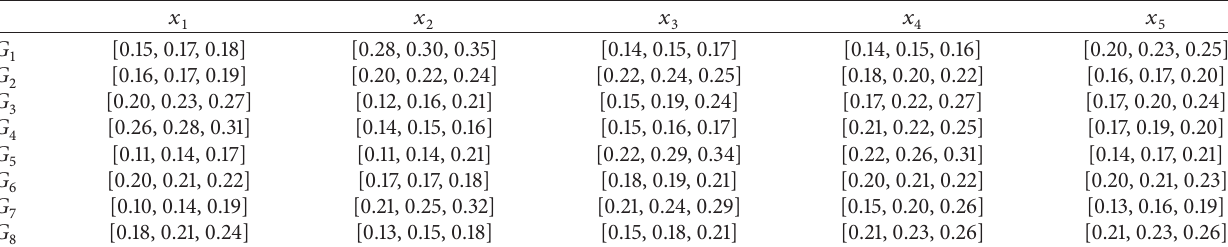
Table 6: Normalized triangular fuzzy number decision matrix 𝑅 (3)